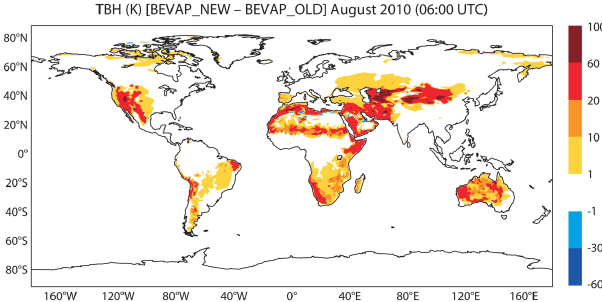
Fig. 6. Map of differences between TB (horizontal polarisation, 40 ◦ incidence angle in K) simulated using model fields from BE- VAP NEW and BEVAP OLD for August 2010